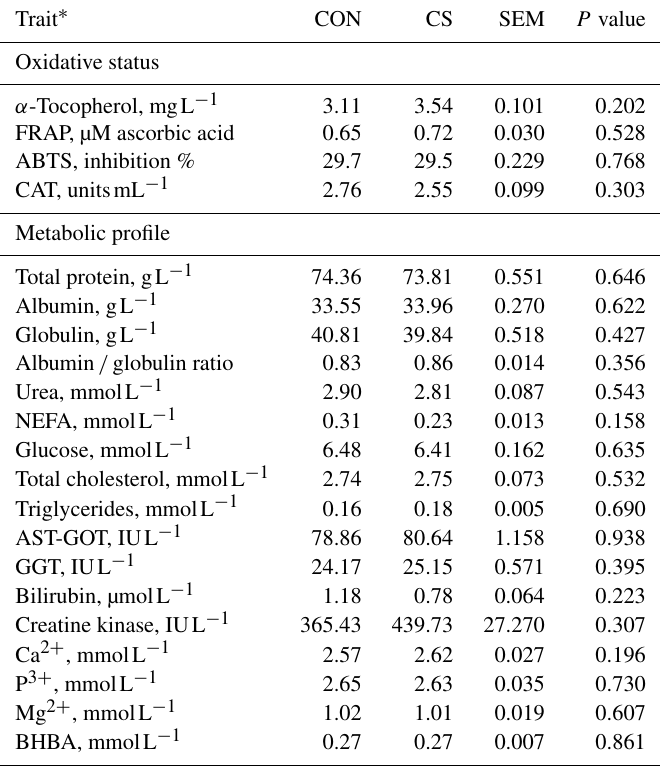
Table 4. Plasmatic oxidative status, and metabolic profile (least-square mean and standard error of the mean – SEM) of animals in the control (CON) and commercial supplement (CS)